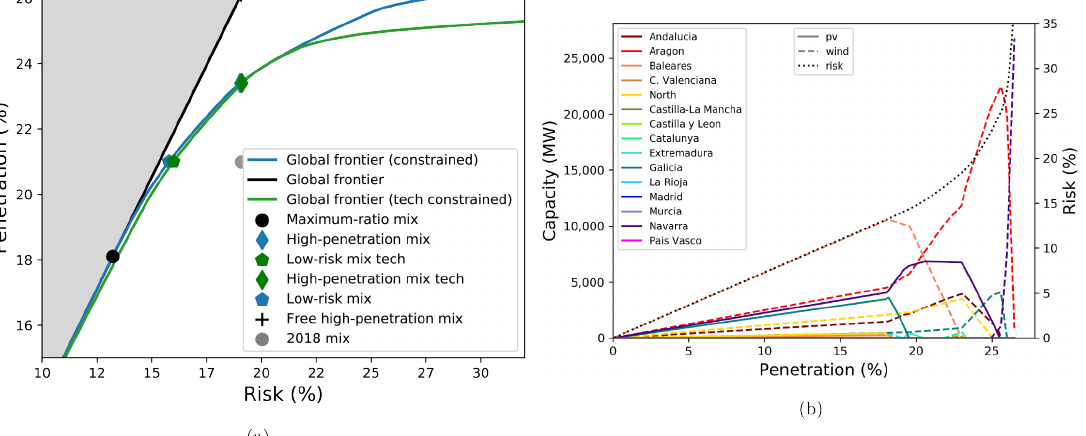
Figure 1. Standard visual representation of the optimization results. ( a ) CTL/CAL penetration-risk diagram with the Pareto optimal front for the two basic optimization processes. Risk is represented √ r , using standard deviation instead of variance. The blue line represents the Pareto optimal as capacity-constrained front and the green line represents the Pareto optimal technology-constrained front. The black line represents the optimal unconstrained front. The black circle represents the maximum-ratio mix, the highest penetration mix where the capacity-constrained and unconstrained front overlap. The gray circle represents the 2018 mix. Blue and green pentagons represent the low-risk mix in both constrained scenarios with, respectively, optimal risk and the same penetration as the 2018 mix. Blue and green diamonds represent the high-penetration mix in both constrained scenarios with, respectively, optimal penetration and the same risk as the 2018 mix. The black cross represents the free high penetration mix, with unconstrained optimal penetration and the same risk as the 2018 mix. ( b ) CTL/CAL installed capacity (IC) evolution along the capacity constrained front (blue line in panel a ). The dotted black line (right y axis) represents total risk of the mix. Risk is represented as Dashed and solid lines (left y axis) show wind and PV ICs respectively. Colors represent